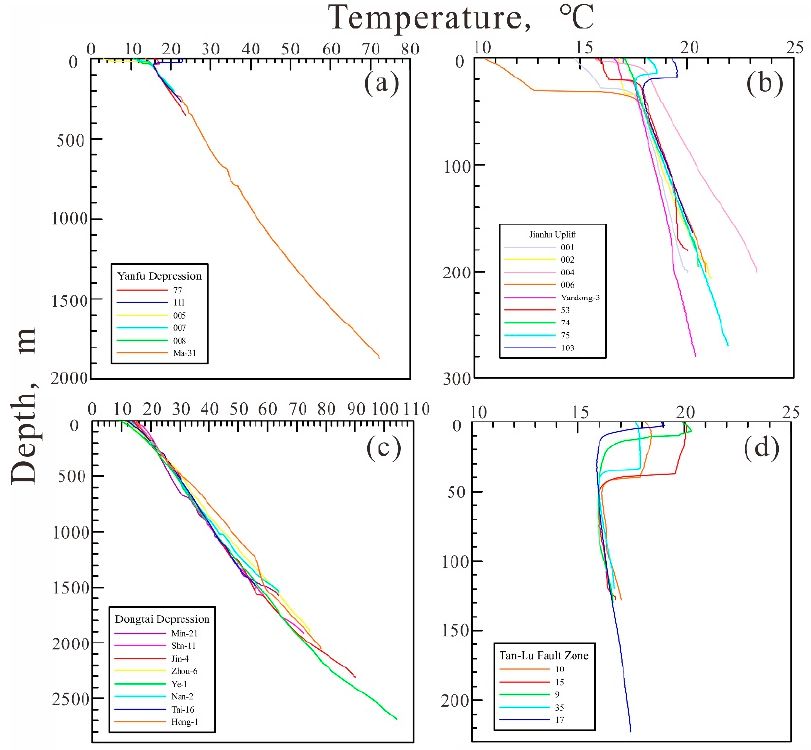
Figure 5. The representative temperature-depth profiles for each sub-structural unit in the North Jiangsu Basi ( a ) Yanfu Depression; ( b ) Jianhu Uplift; ( c ) Dongtai Depression; ( d ) Tan-Lu Fault Zone. (modified from Wang, et al. [4]. Reprint with permission [4].